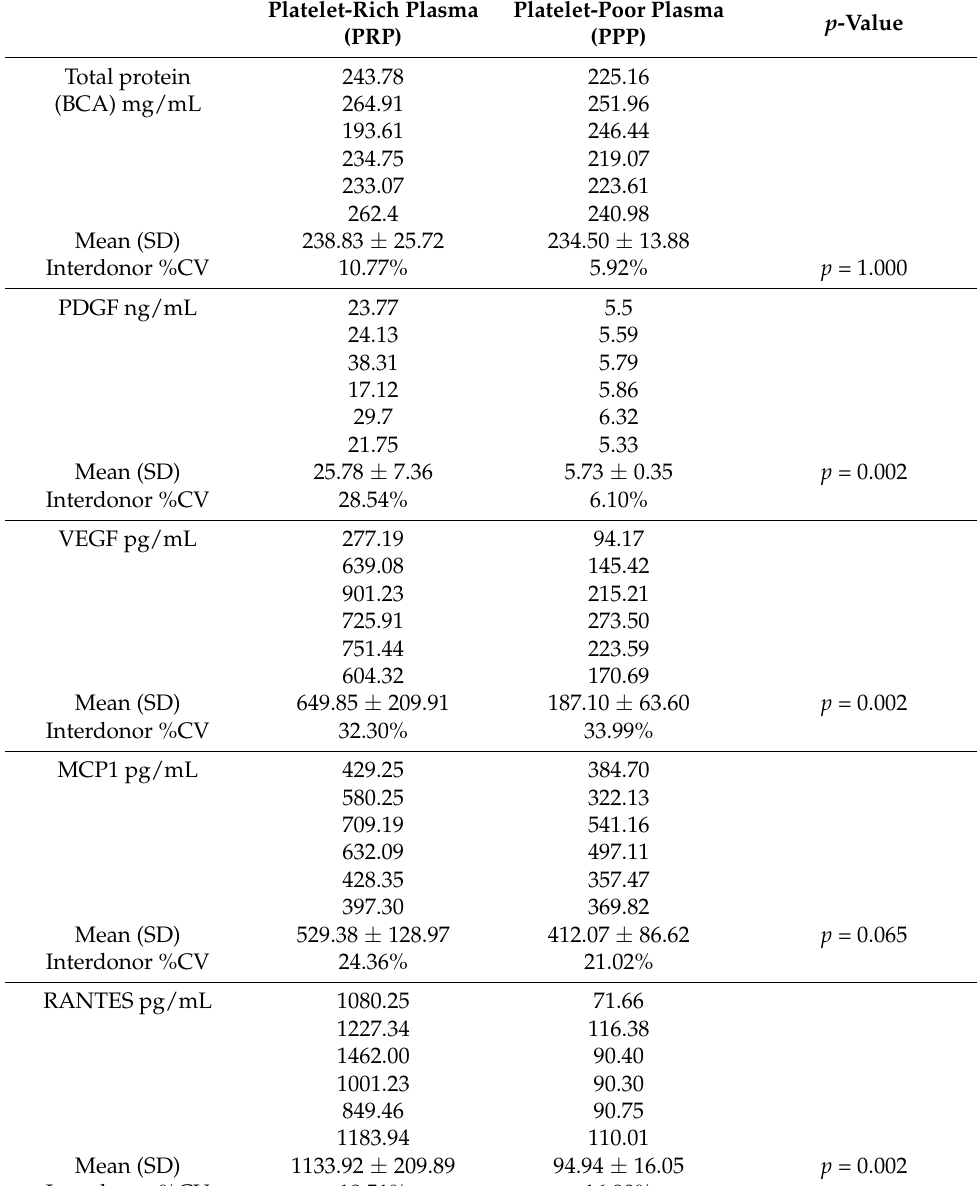
Table 3. Molecular characterization (ELISA) of the individual components of the